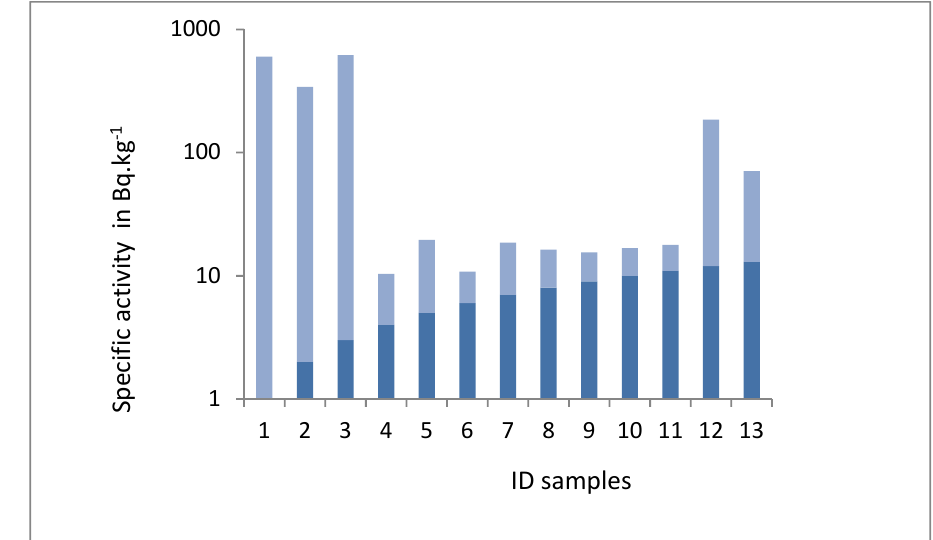
Fig.2: The specific activity of 60 Co in the samples collected from an among processing